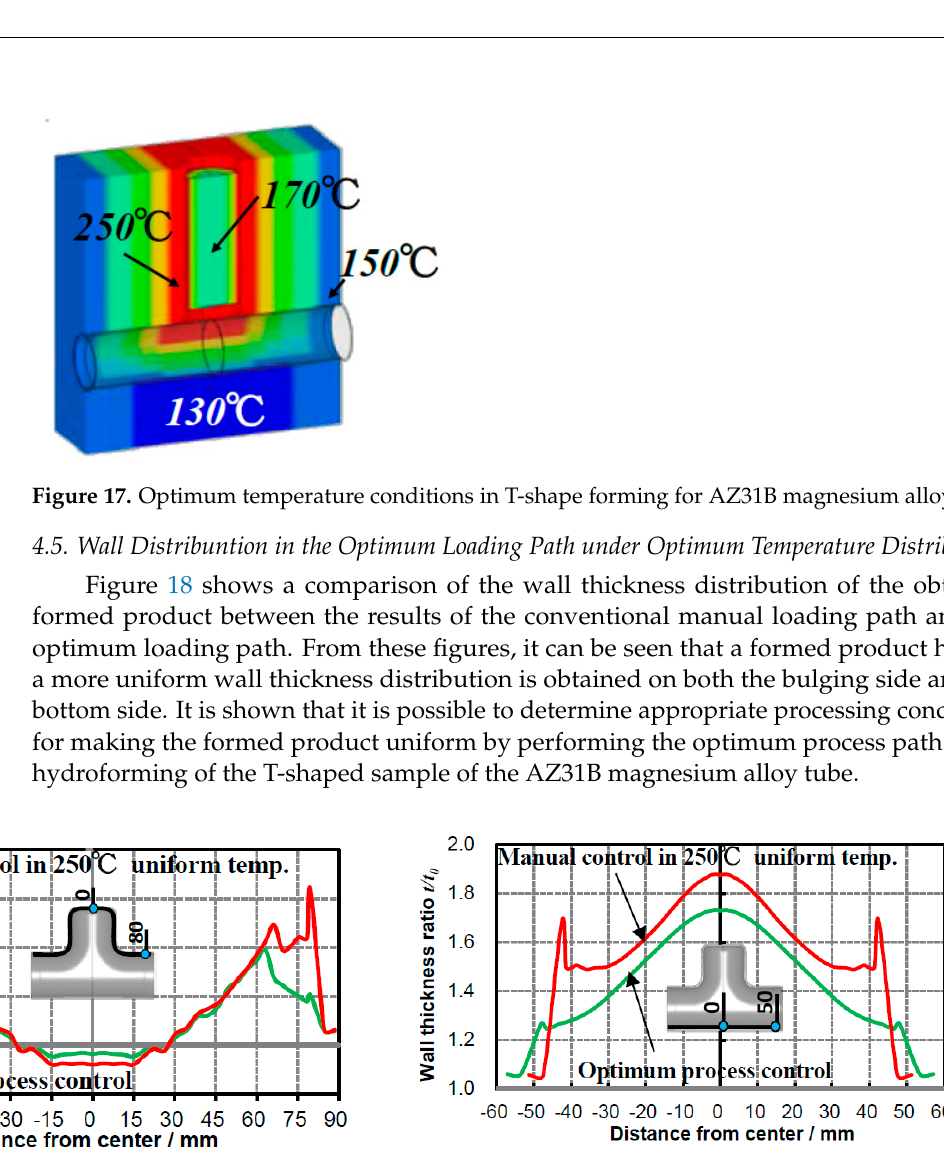
( a ) Bulge side; ( b ) bottom side.